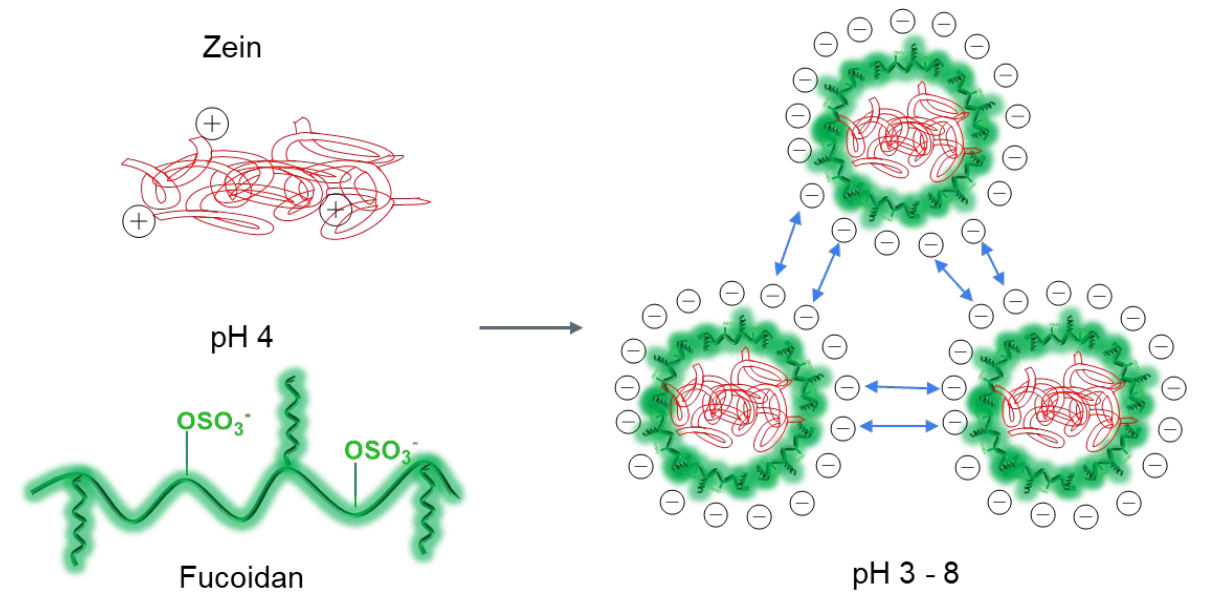
Figure 5. Scheme of formation of interpolymer complexes based on FUC macromolecules and zein NPs: ionic interaction of two oppositely charged polymers leads to the formation of systems stable in the pH range of 3 – 8, due to electrostatic repulsion of negative charges on the surface of zein NPs. Zhang et al. [36] obtained composite of zein and FUC ( L. japonica , viscosity 3 – 15 cP, MW 50 – 200 kDa, sulfate content 25.5%, L-fucose 24.6%, other monosaccharide 7%) NPs